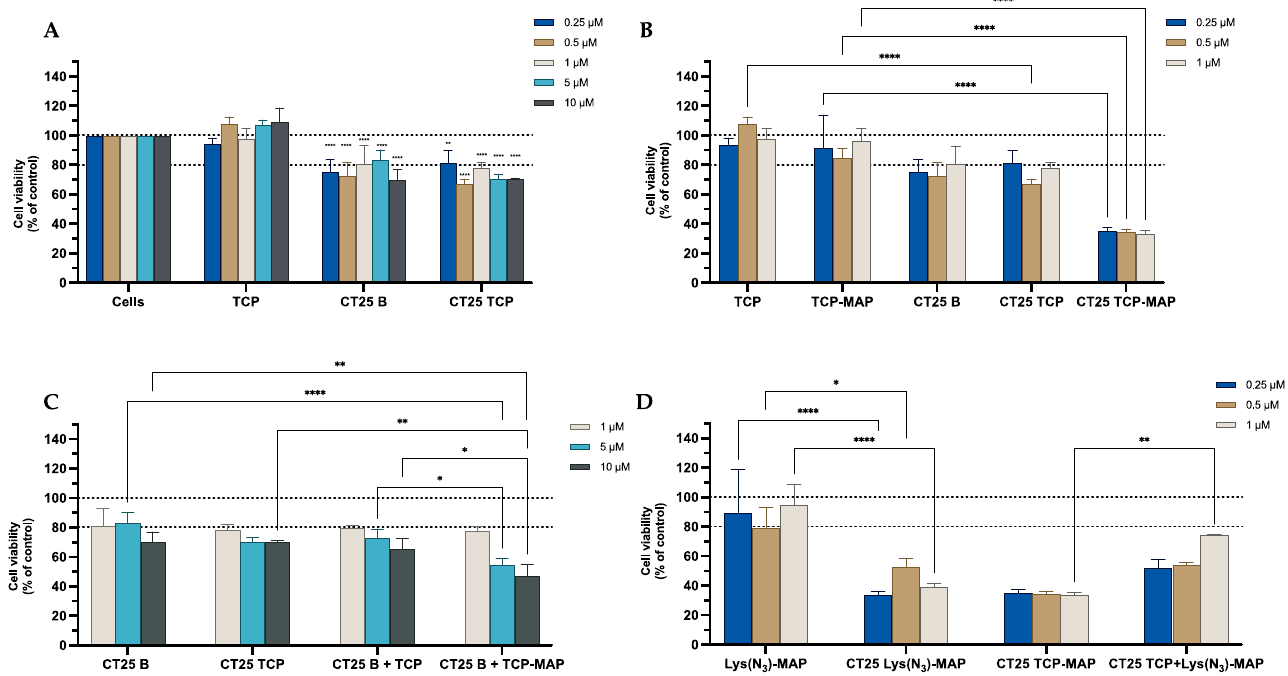
Figure 11. Relative cell viability of SH-SY5Y cell line measured by the MTT reduction after 24 h incubation. ( A ) represents NLC safety test with the treatment of free TCP, blank CT25 and TCP-loaded CT25 (0.25–10 µ M). ( B ) Represents differences in the cell viability of treatment with free TCP, TCP-MAP, blank CT25, TCP-loaded CT25, MAP, TCP-MAP-loaded CT25 (0.25–10 µ M). ( C ) Represents co-administration of TCP and TCP-MAP with blank CT25 (1–10 µ M). ( D ) Represents the data obtained from the encapsulation of Lys(N 3 )-MAP and co-encapsulation of TCP and Lys(N 3 )-MAP in the NLC compared to peptide conjugate. Results are expressed as means ± SD (n = 4). Statistical analysis between the groups was performed using two-way ANOVA with Tukey’s multiple comparisons test (* p < 0.05; ** p < 0.01; **** p <